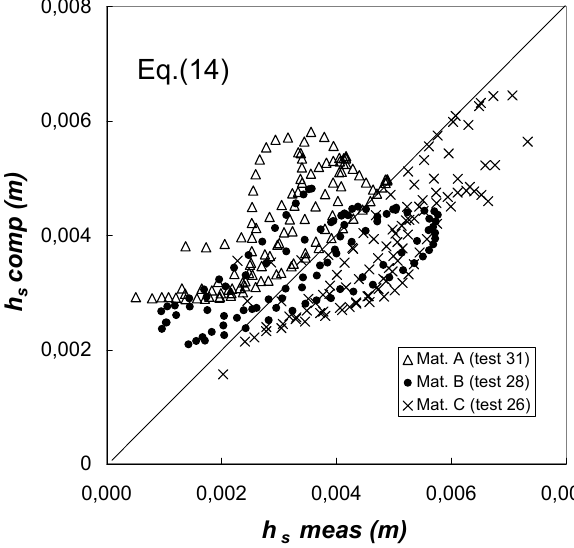
Fig. 15. Measured and computed (Eq. 14) values of moving layer Figure 15. Measured and computed (Eq.14) values of moving layer depth.